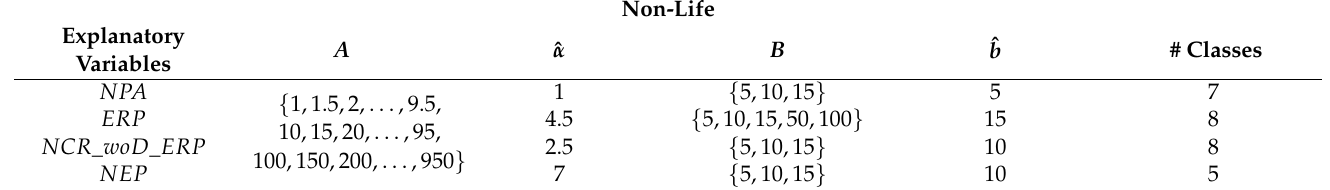
Table A6. Parameters of the evtree for non-life undertakings.